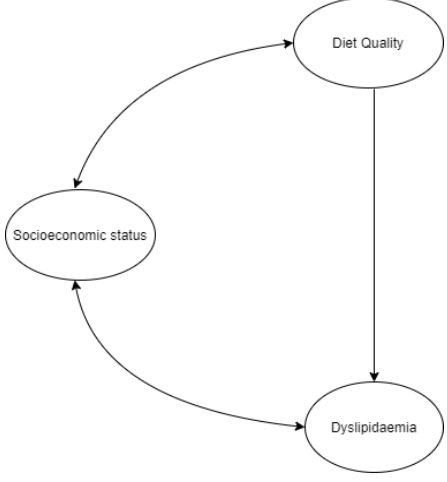
Figure 1. Hypothesised